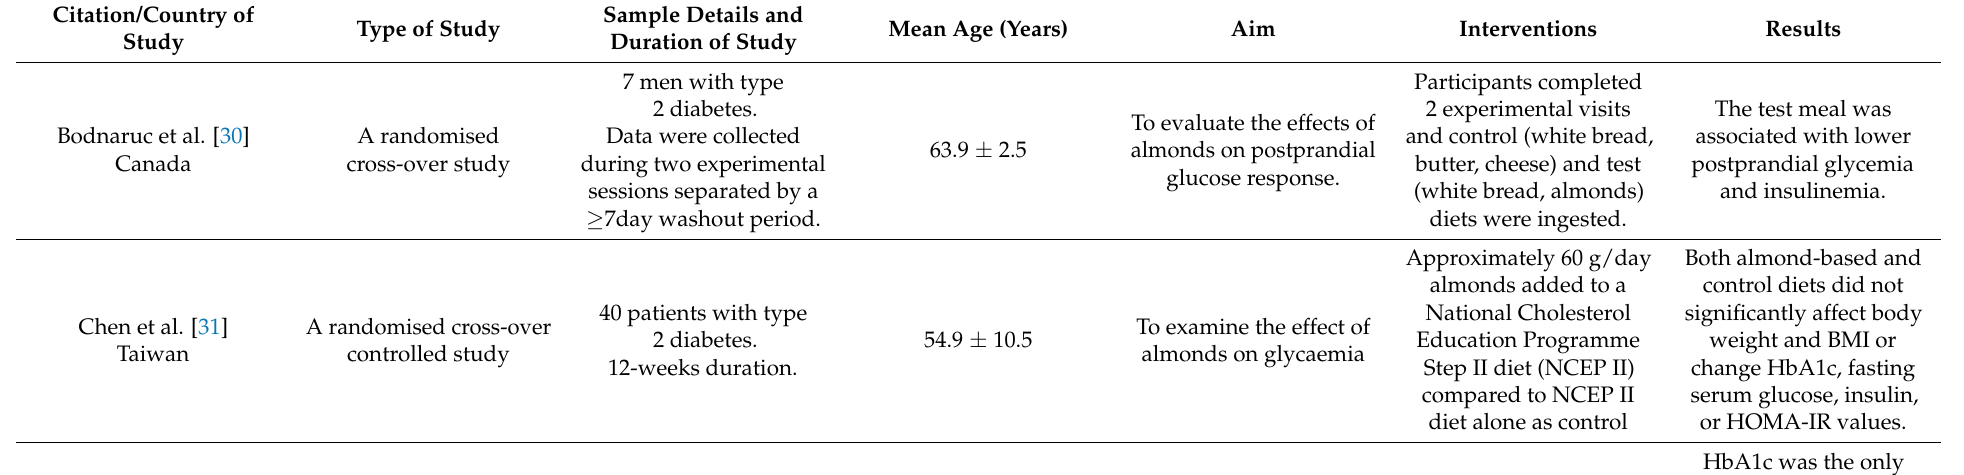
Table 2. General characteristics of included